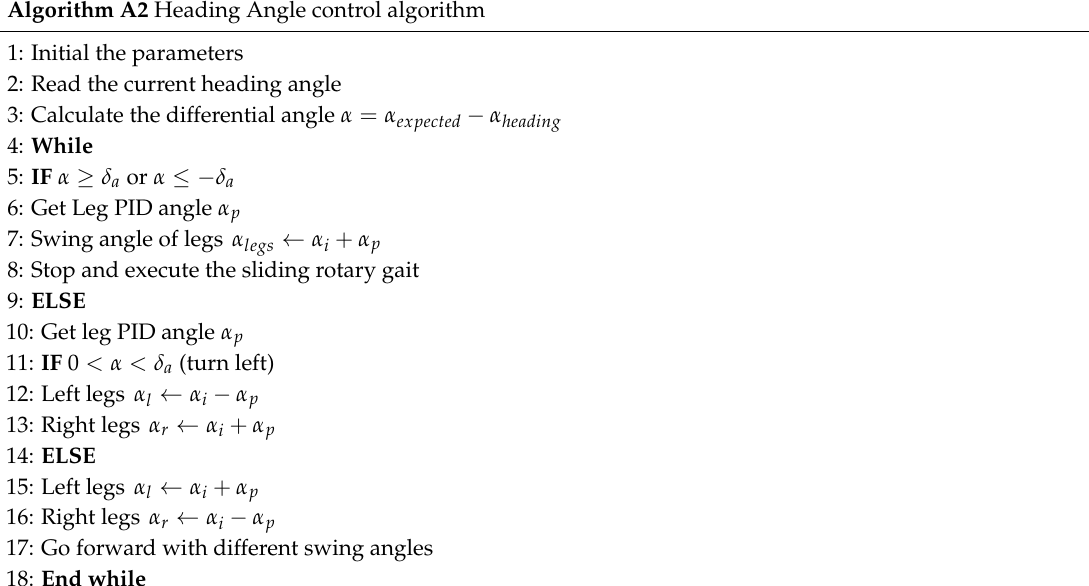
Algorithm A2 Heading Angle control